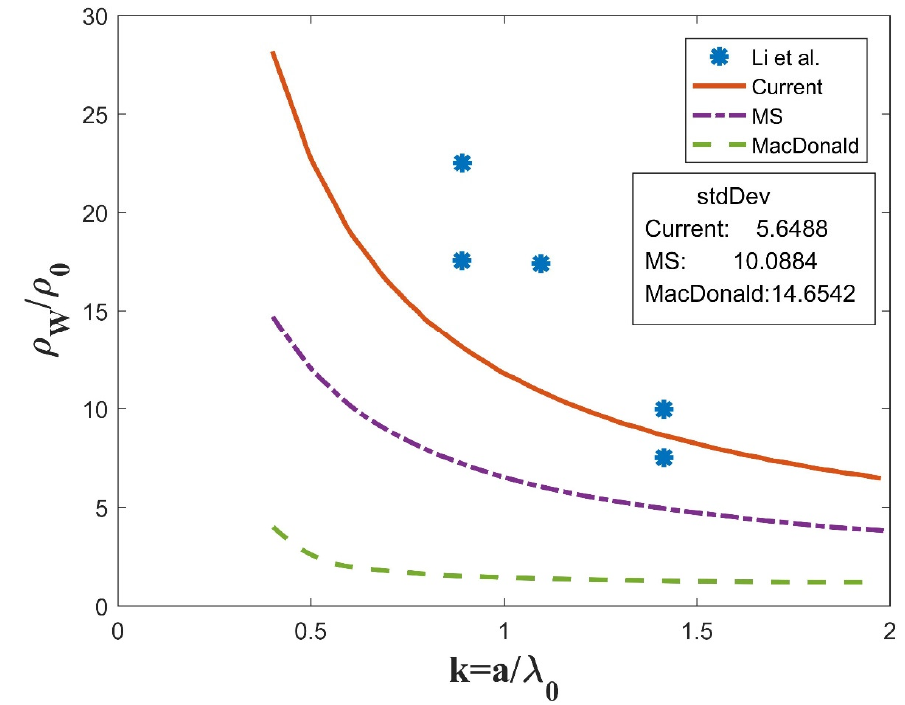
Figure 5. Comparison between numerical simulations and experiment data for ErSi 2 with parameters p = 0.6, R = 0.8, C =